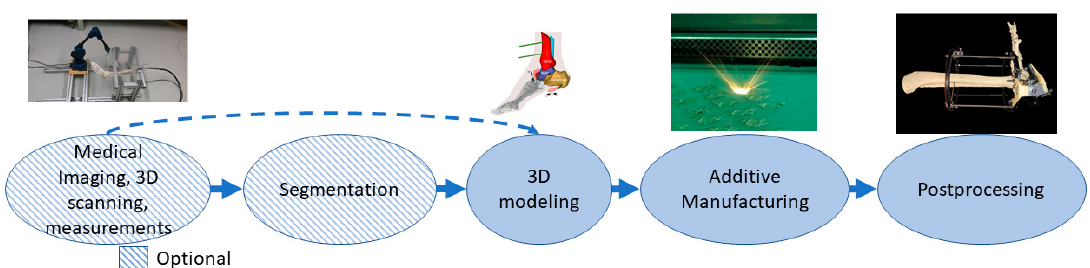
Figure 5. The typical process flow for medical aids, supportive guides, splints and prostheses.